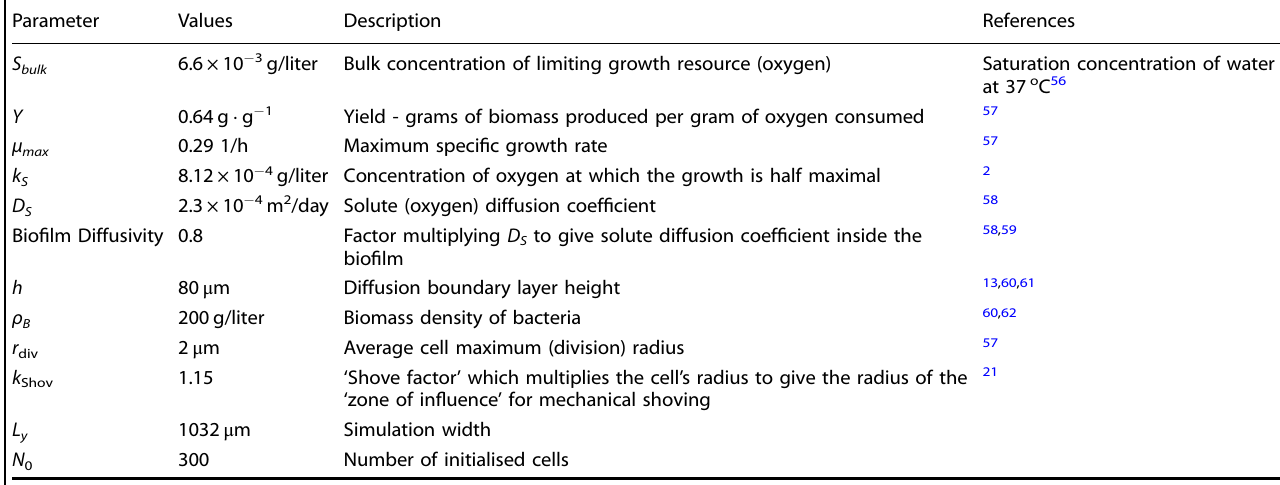
Table 1. Table of the input values used in our iDynoMiCS bio fi lm simulations.